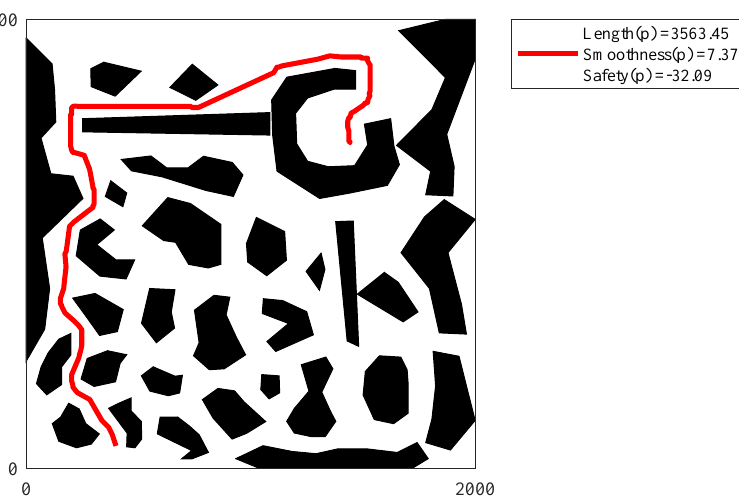
Figure 29. Path of the knee point generated via NSGA-II for Figure 11B.